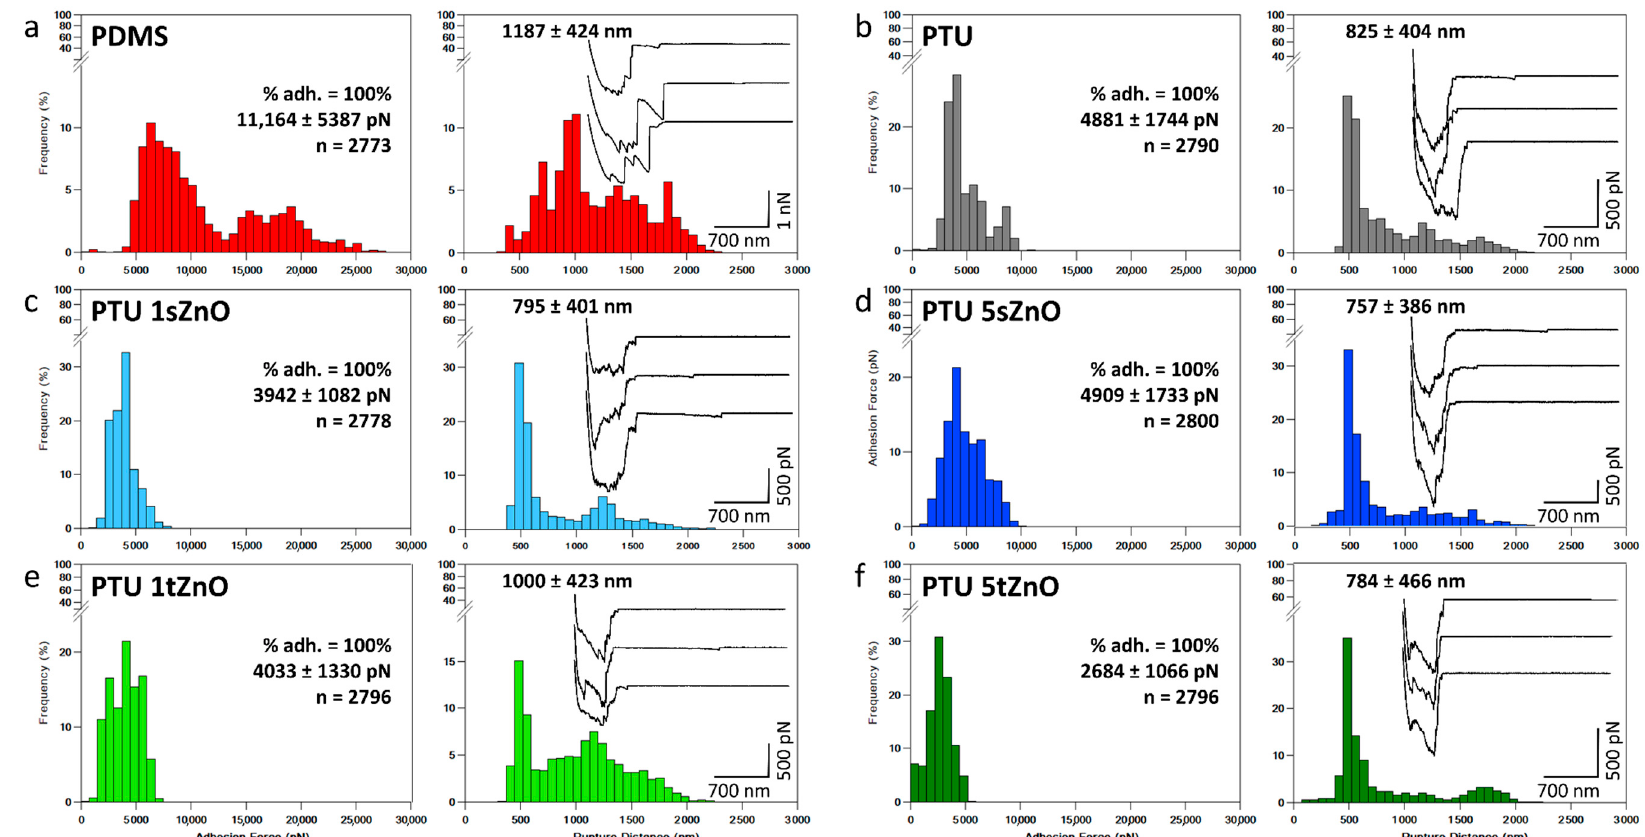
Figure 2. Single-cell force spectroscopy to probe the interactions between C. glabrata and material surfaces. Adhesion force histogram and corresponding rupture distance histogram obtained for seven cells interacting with ( a ) PDMS surface, ( b ) PTU surface, ( c ) PTU containing 1 wt.% of s-ZnO, ( d ) PTU containing 5 wt.% of s-ZnO, ( e ) PTU containing 1 wt.% of t-ZnO and ( f ) PTU containing 5 wt.% of s-ZnO. Insets in rupture distance histograms show representative force curves obtained in each case. % adh. is the % of force curves presenting adhesive events. Data were recorded using a set-point of 0.25 nN.